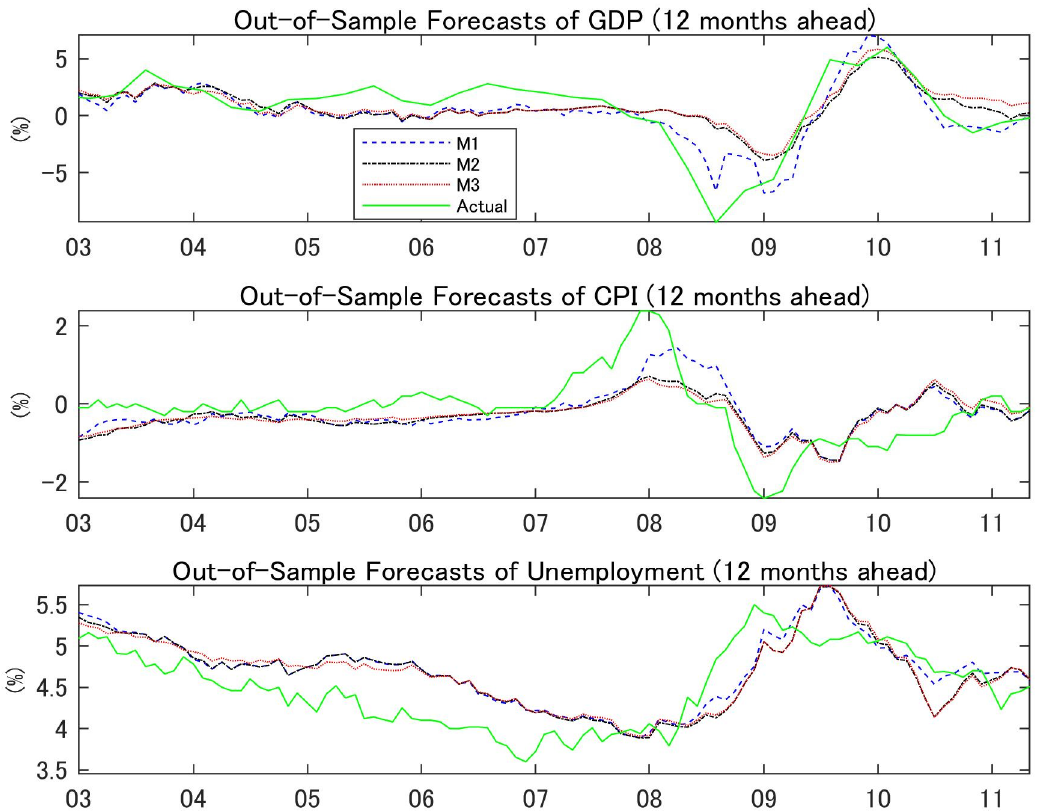
Figure 4. Out-of-Sample Forecasts of Economic Activity Indicators. Note: The panels depict out-of-sample forecasts of GDP, CPI, and UE for a 12-month horizon. The figure shows forecasts by M1 (dashed line), M2 (dashed dotted line), M3 (dotted line), and actual data (solid line).